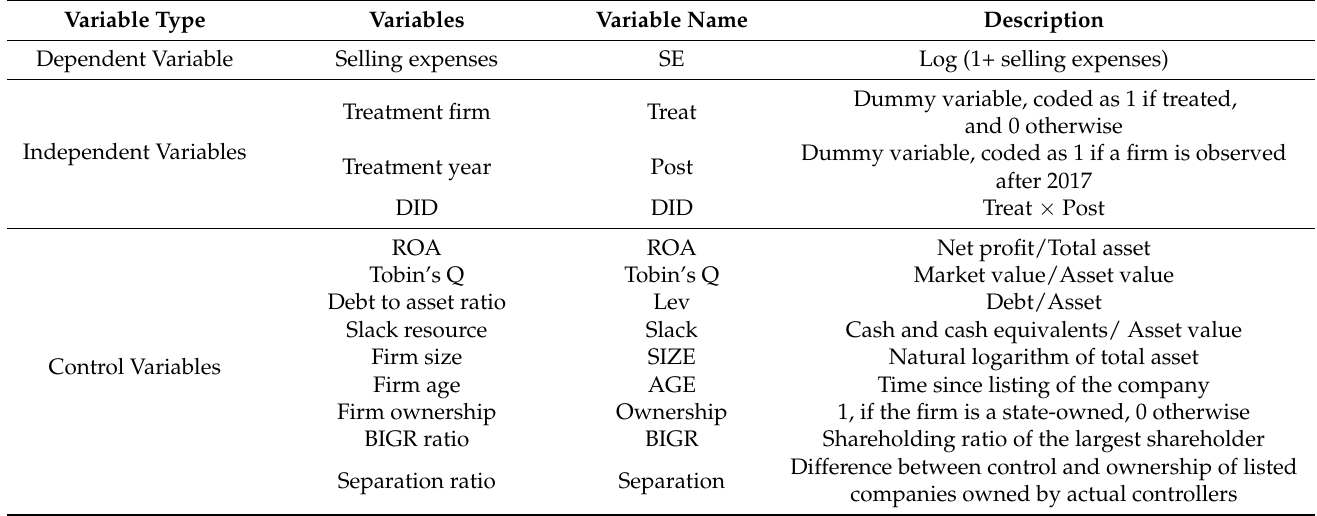
Table A1. Variable Description and